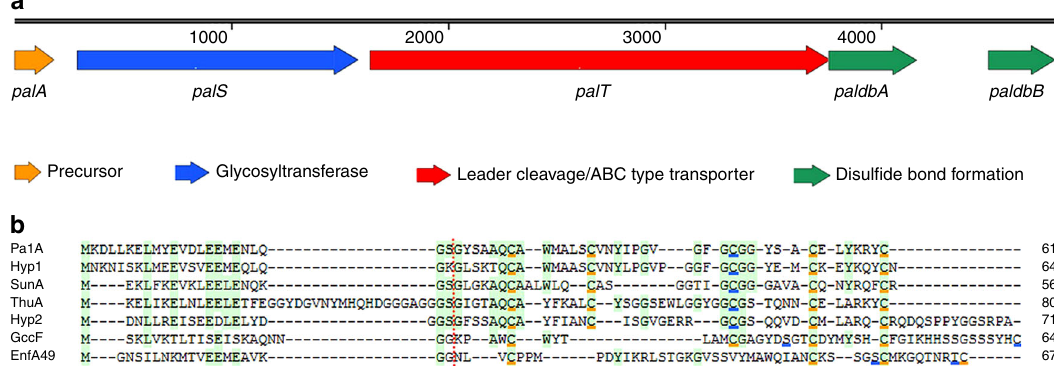
Fig. 1 Gene cluster and precursor peptides of glycocins. a Pallidocin biosynthetic gene cluster (4805 bp) pal identi fi ed by BAGEL4 in A. pallidus 8 genome. b Alignment of glycocin precursor peptides. Conserved regions are highlighted in green color, Cys forming disul fi de bonds are underlined in orange, glycosylated amino acids are underlined in blue. Red dots between amino acids indicate predicted or experimentally determined leader cleavage sites. Numbers in the end of the sequences indicate the length of peptides in amino acids. PalA pallidocin precursor, SunA sublancin precursor, Hyp putative glycocin precursor Hyp1, Hyp2 putative glycocin precursor Hyp2, EnfA4-9 enterocin F4-9 precursor, GccF glycocin